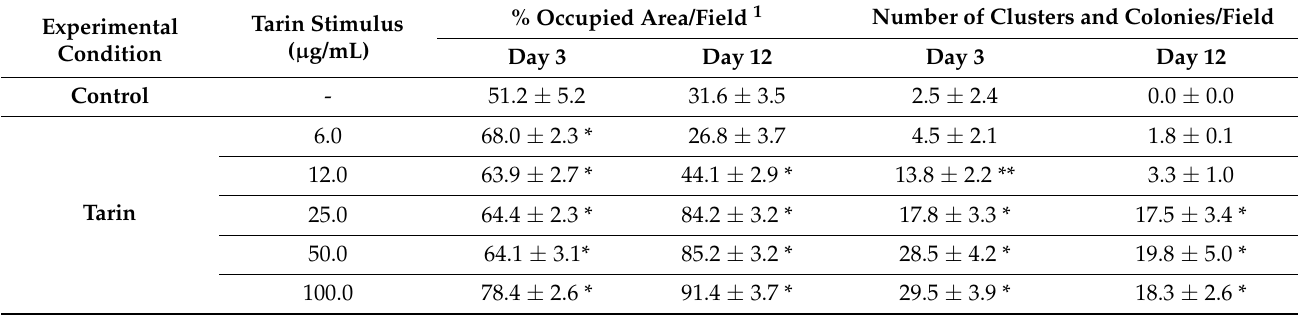
Table 1. Dynamic response of bone marrow cells treated with tarin.